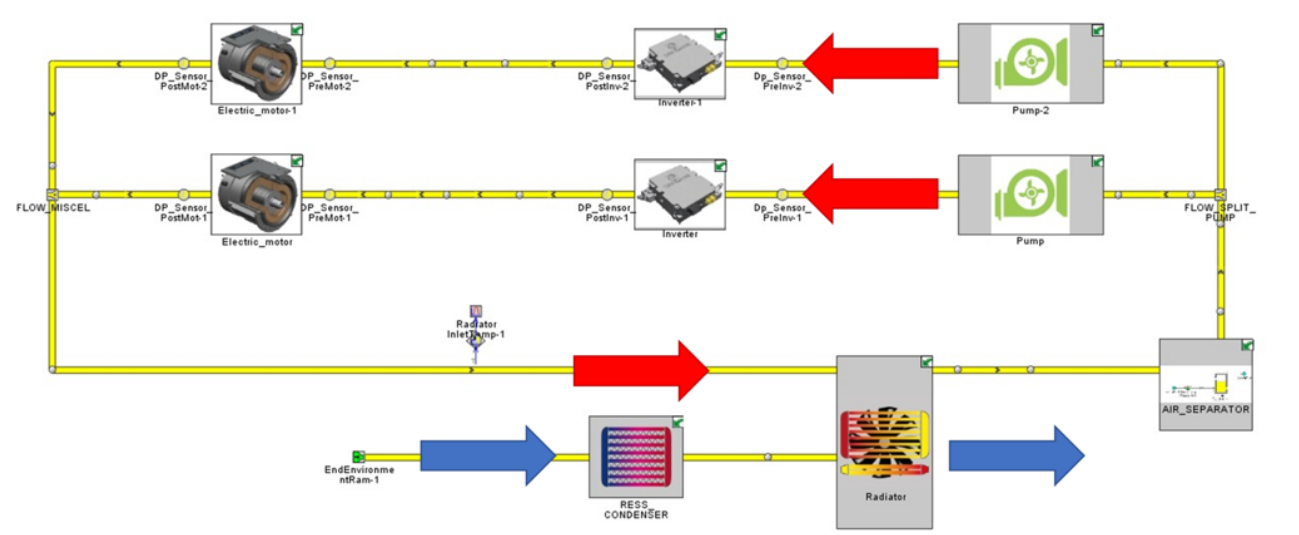
Figure 8. Propulsion cooling system model in GT-Suite (dual e-motor configuration).